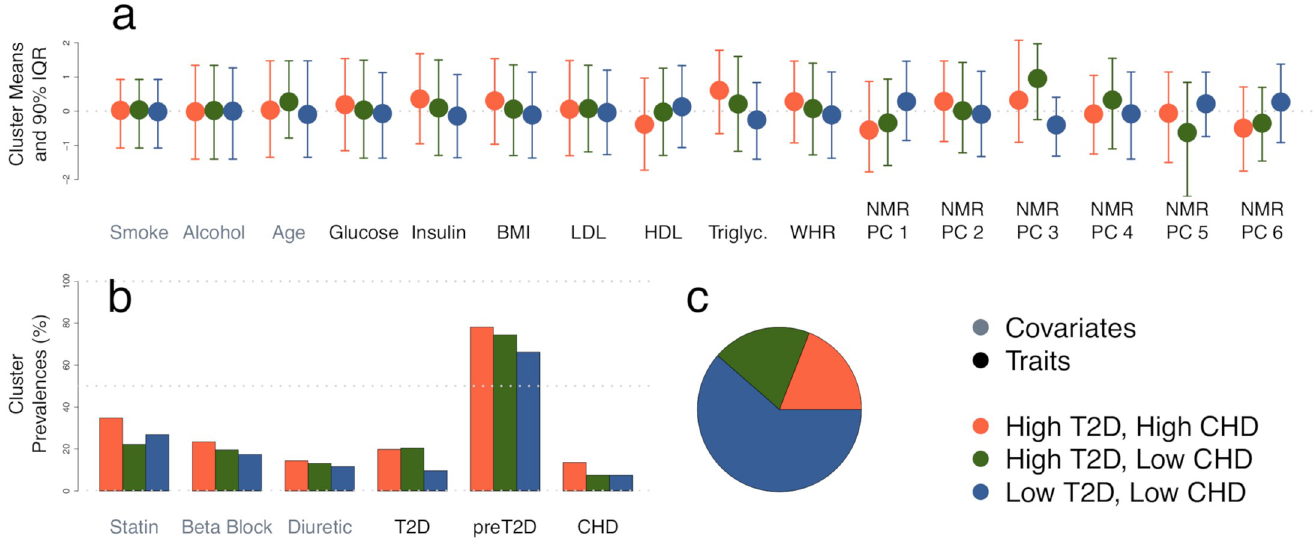
Fig 3. Three inferred metabolic subtypes in METSIM. (a) Quantitative and (b) binary distributions for covariates (grey labels, left) and traits (black labels, right). (c) Subtype sizes.